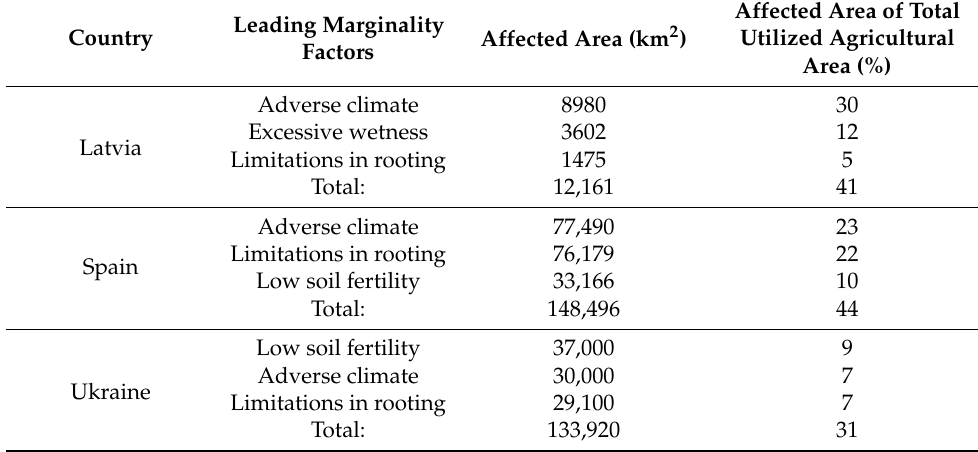
Table 1. Leading marginality factors affecting countries where case studies were carried out (accord- ing to MAGIC-Maps